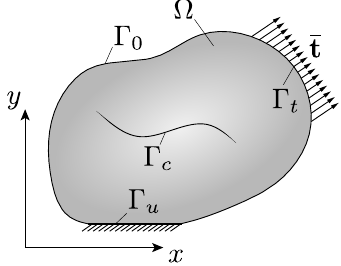
Figure 1. Cracked Body and boundary